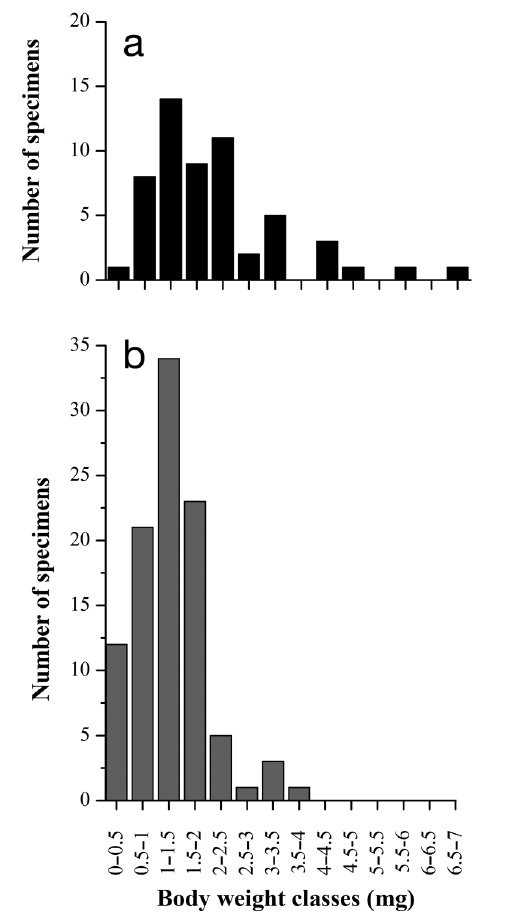
Fig. 4. Body weight frequencies of (a) Hydroides dirampha and (b) H. elegans